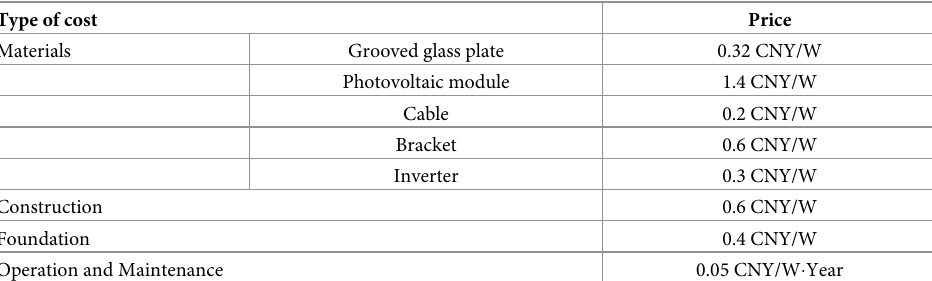
Table 7. The installation and maintenance costs of